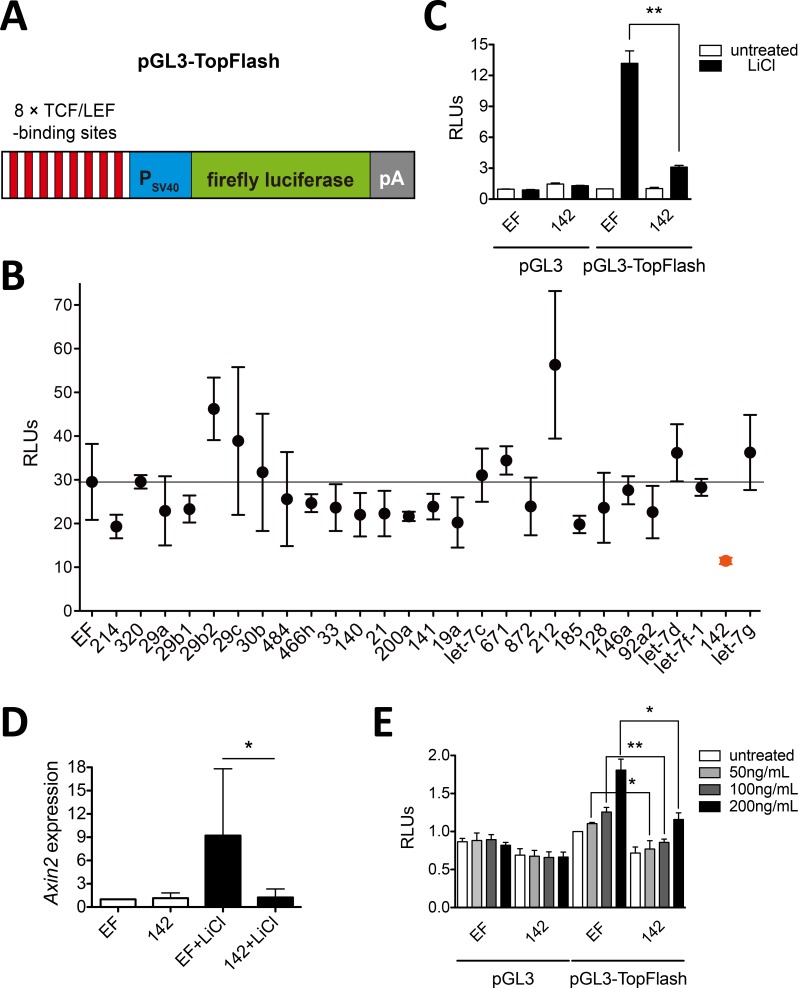
Among candidate miRNAs, miR-142 negatively regulates Wnt/β-catenin signaling.(A) Schematic representation of the pGL3-TopFlash reporter. Eight tandem repeats of TCF/LEF response elements were introduced upstream of the SV40 promoter and firefly luciferase gene (Luc) in pGL3 promoter vector. (B) Screening for inhibitors of Wnt/β-catenin signaling. Plasmids pGL3-TopFlash, pRL-TK and miRNA-expressing vectors were cotransfected into HEK293T cells. Cells were treated with 25 mM LiCl 6 h posttransfection, and lysed 24 h posttransfection for dual-luciferase analysis (RLUs, Fluc/Rluc). (C, E) miR-142 inhibits the activated Wnt/β-catenin signaling. Wnt/β-catenin signaling was activated by 25 mM LiCl (C) or increasing doses of Wnt3a (E). TopFlash-mediated firefly luciferase activities (B, C, E) were normalized to the activity of Renilla luciferase (pRL-TK); error bars mark the SEM (n = 3; **P < 0.01, *P < 0.05, t test). (D) miR-142 represses expression of Axin2. miR-142 expressing vector or empty vector (EF) was transfected into HEK293T cells with or without 25 mM LiCl treatment. Axin2 mRNA expression was analyzed by quantitative RT-PCR, the data shown were normalized by Actb expression; error bars mark the SEM (n = 2; *P < 0.05, t test).